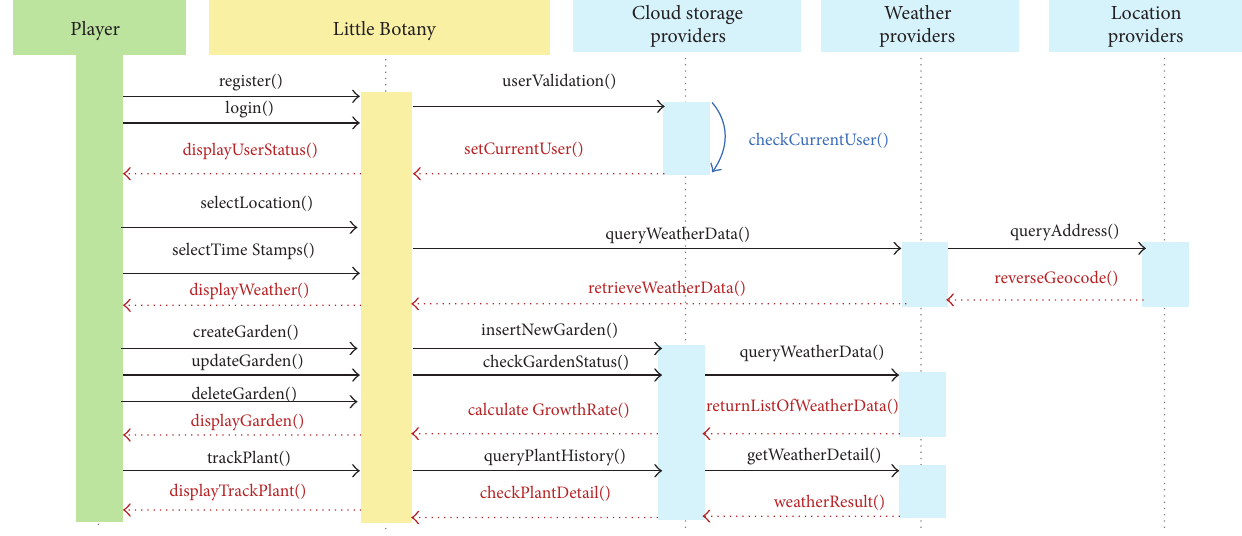
Figure 1: An illustration of player activities in Little Botany.